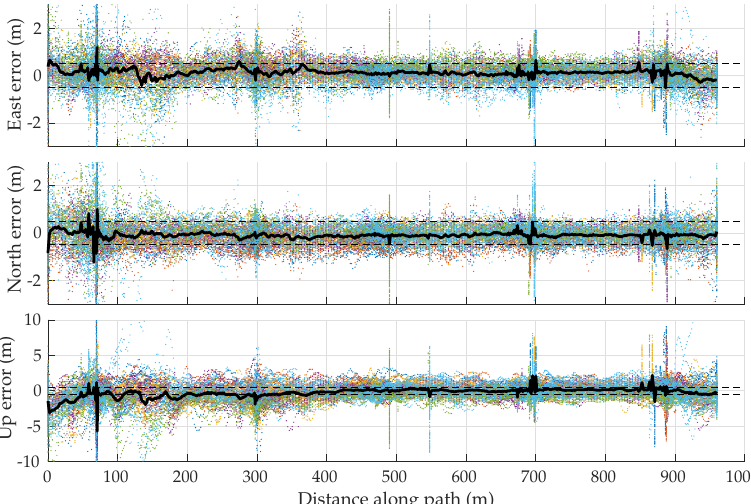
Figure 15. Errors in double-differenced pseudorange-based position estimates with respect to ground truth in the east, north, and up directions. Different colors distinguish data from six different campaigns. Dashed reference lines are drawn at ± 50 cm. The solid black lines show the mean positioning error over the six campaigns. The error standard deviation in the east and north directions is ∼ 0.9 m over the first 200 m along the path and ∼ 0.4 m over the rest. In the up direction, the standard deviation is ∼ 1.9 m over the first 400 m and ∼ 1 m over the